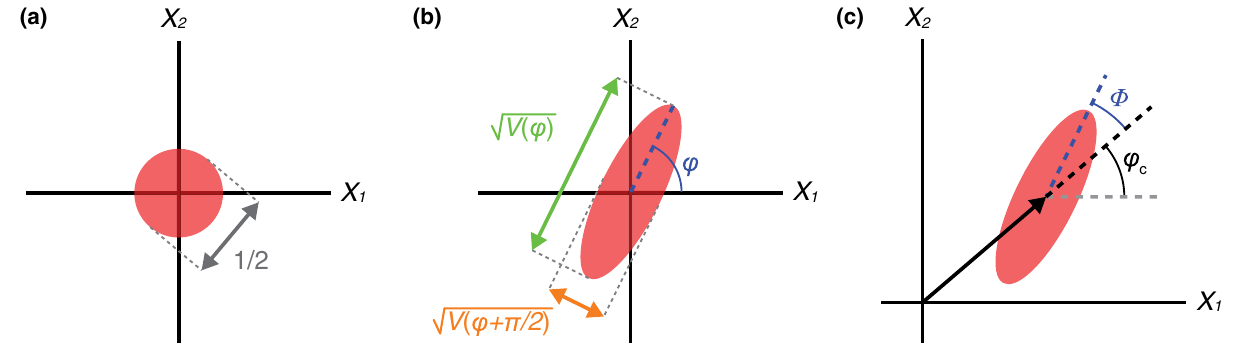
FIG. 6. States of light can be fully described by quasiprobability distributions (here, Wigner functions) in phase space, where X 1 and X 2 are the two quadratures of the light field. (a) The vacuum state is described by a circular Gaussian distribution of width 1 = 2 centered at the origin. The red disk indicates the area in which the distribution is greater than its half-maximum value. (b) The distribution for a squeezed vacuum state has an increased width along the amplification axis at angle φ and a decreased width along the squeezing axis at angle φ þ π = 2 . A slice of this distribution taken through the origin at angle θ has a variance given by Eq. (1) of the main text, with the amplified variance given by 1 = 2 ð N þ M þ 1 = 2 Þ and the squeezed variance given by 1 = 2 ð N − M þ 1 = 2 Þ . Note an angular factor of 2 has been introduced in Eq. (1) in the main text compared to Refs. [7,8] to simplify the phase-space picture. (c) Similarly, Φ , as used in Fig. 3 of the main text, indicates the angle of the amplification axis of a displaced squeezed state relative to the displacement angle, φ Experimentally, φ is set by the phase of the coherent Rabi c